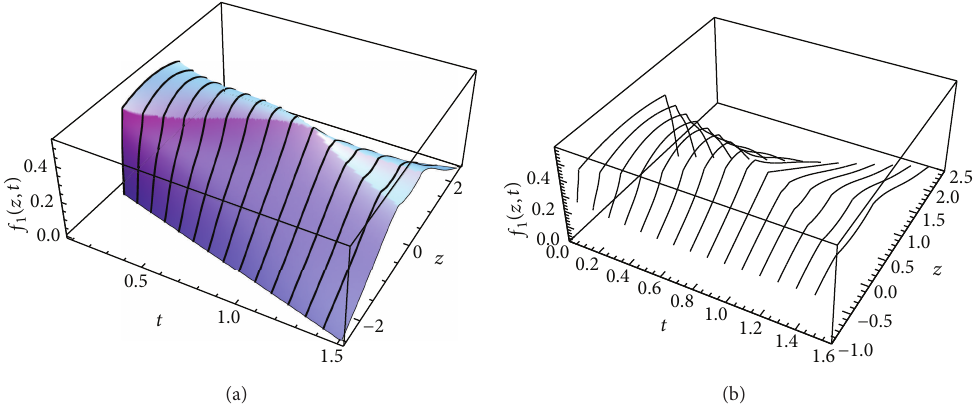
Figure 6: Plot of 𝑓 1 (𝑧,𝑡) given by (79)-(80) in Example 15 at different values of 𝑡 = {0, 0.1, 0.2, .. . ,1.5} (corresponding to the solid lines in both plots) in the case that (𝑍 0 ,𝐵) is a two-dimensional RV whose PDF is given by (77) and 𝑡 0 = 0